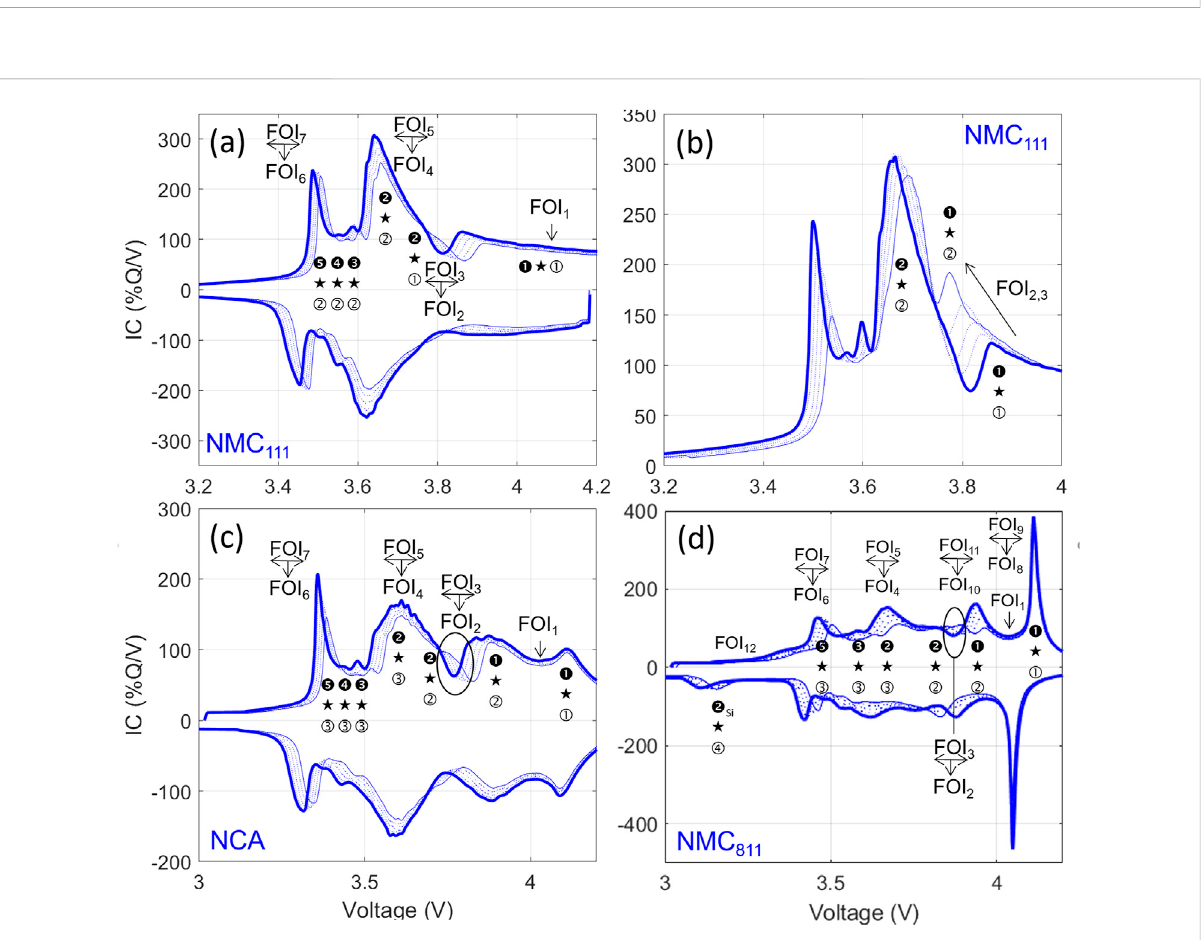
FIGURE 10 Peak evolution from the pristine cell (thick line) to 15% LLI, 10% LAM PE , and 10% LAM GIC (thin line) and intermediates (dotted lines) for (A) GIC/ NMC111, (C) GIC/NCA, and (D) (GIC,Si)/NMC811. (B) Effects of NE rate capacity degradation on a GIC/NMC111 cell (C/10 simulation with up to 10% LAM NE with a 4x worsening of the kinetics and an 80% increase of